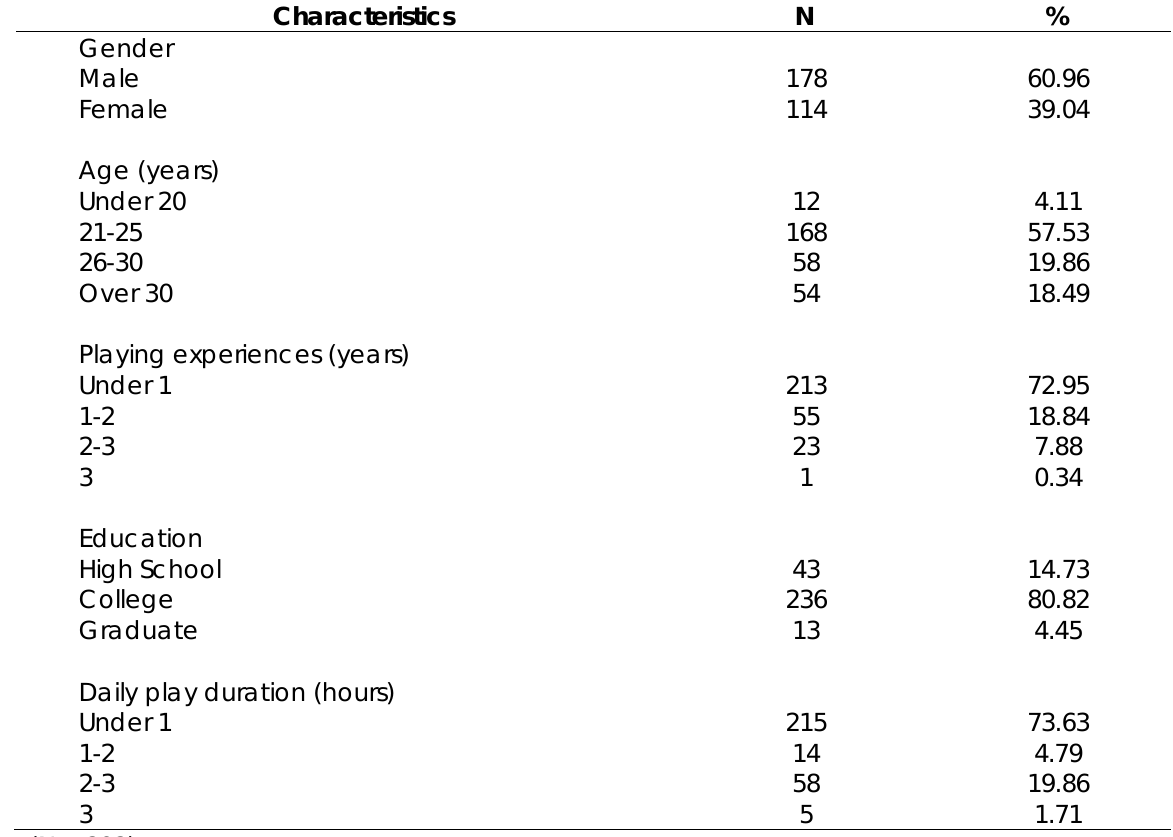
Demographic Overview of